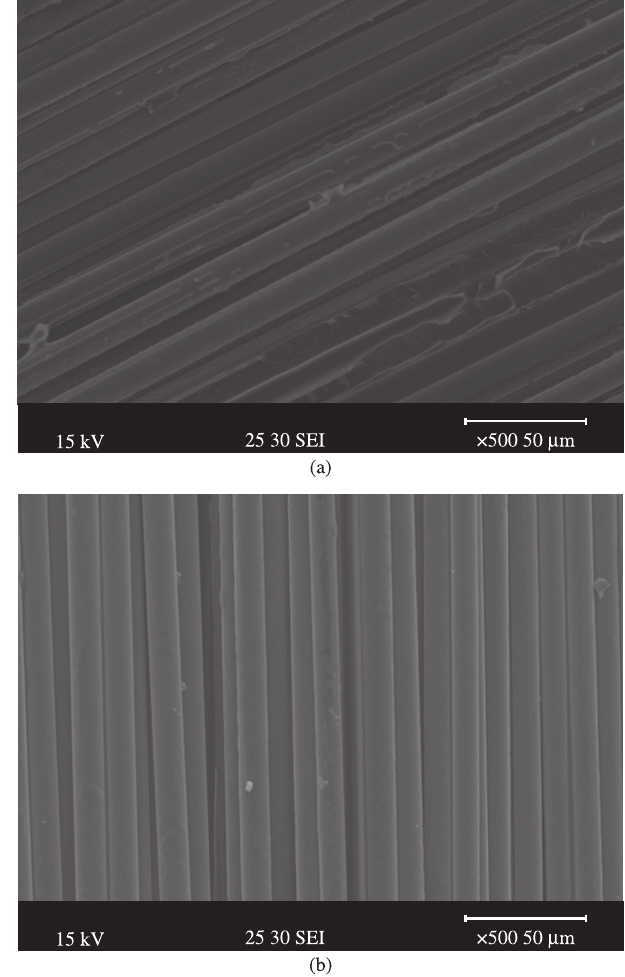
Figure 8. SEM micrographs of glass fibers (a) dry and (b) after washing in distilled